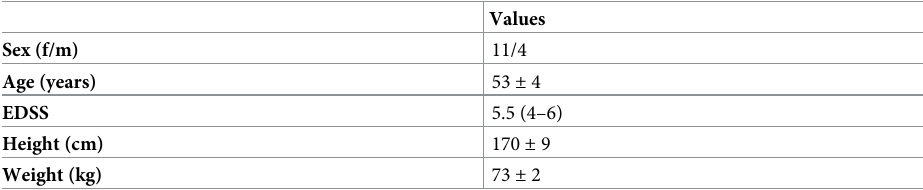
Table 1. Characteristics of